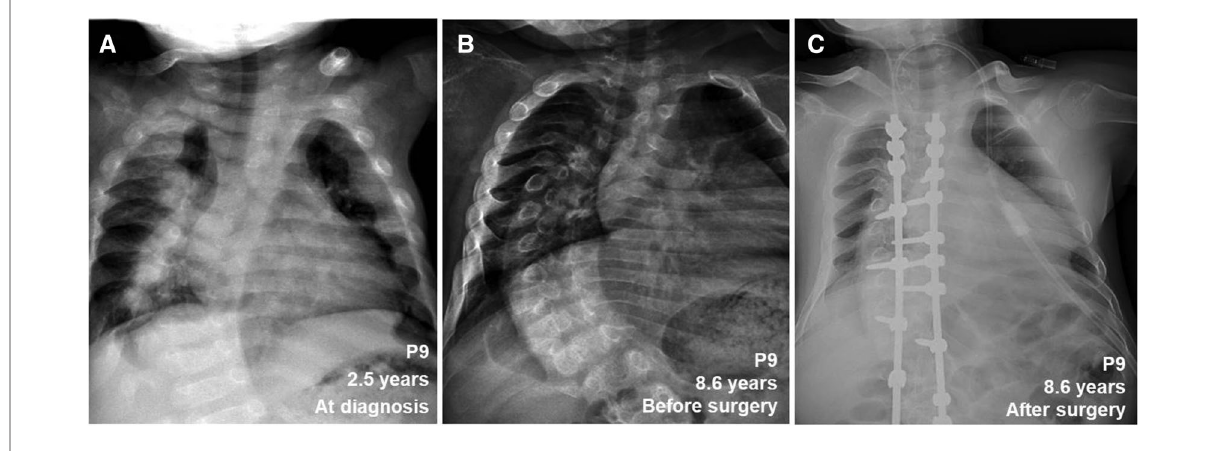
FIGURE 5 Comparison of skeletal x-ray images of VDDR1A patient P9 at diagnosis and after treatment. ( A ) At diagnosis, ( B ) after treatment was discontinued, ( C ) after